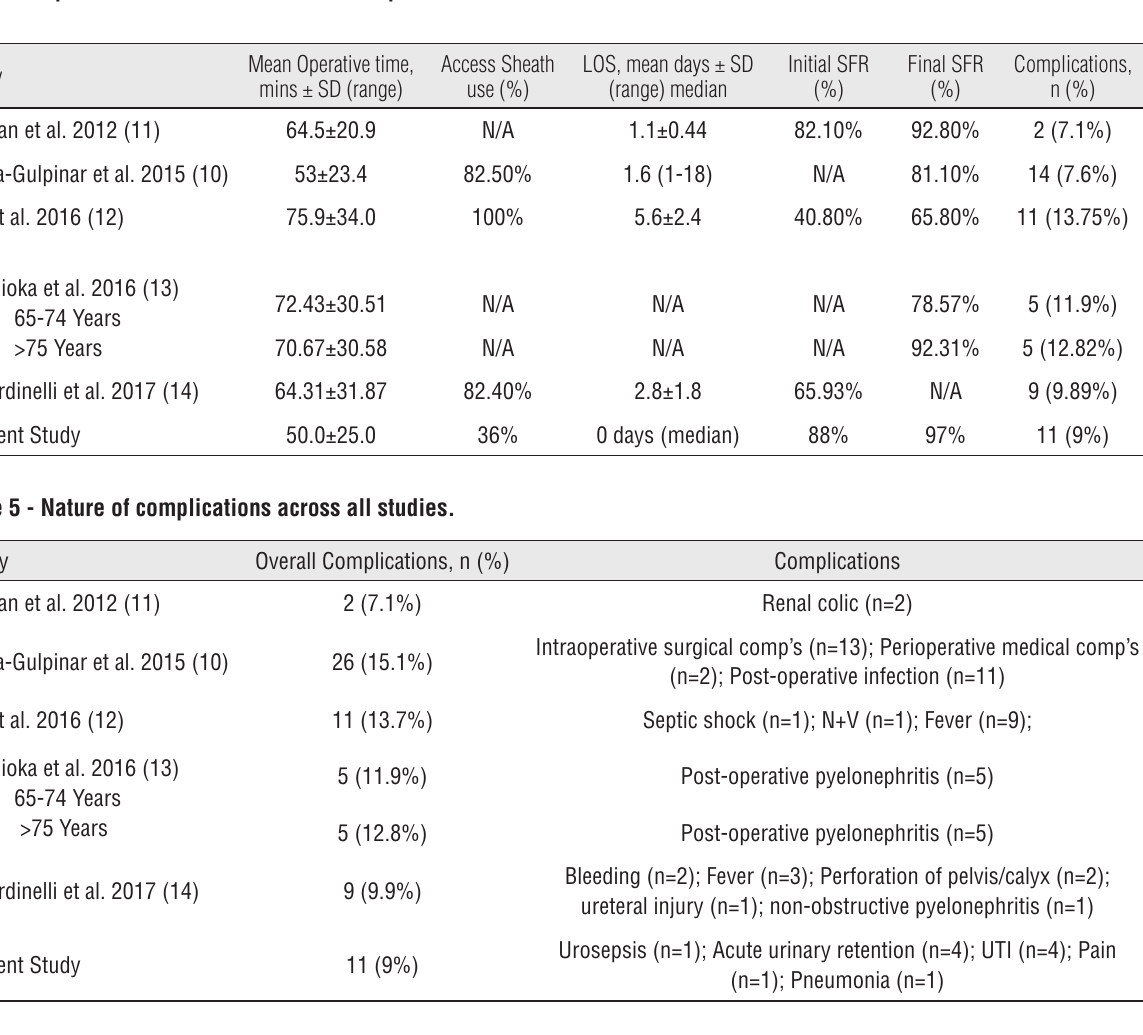
Table 4 - Operative details in other studies reported in the literature.